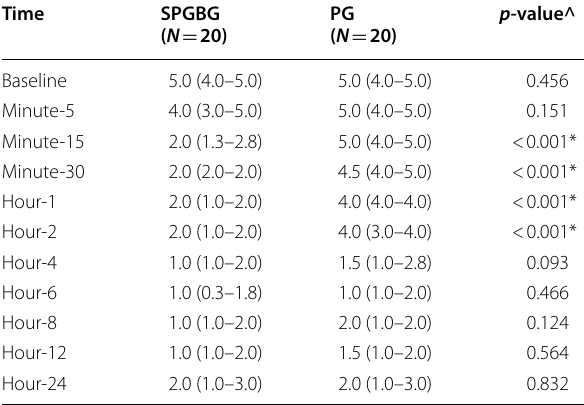
Table 3 Comparison regarding pain